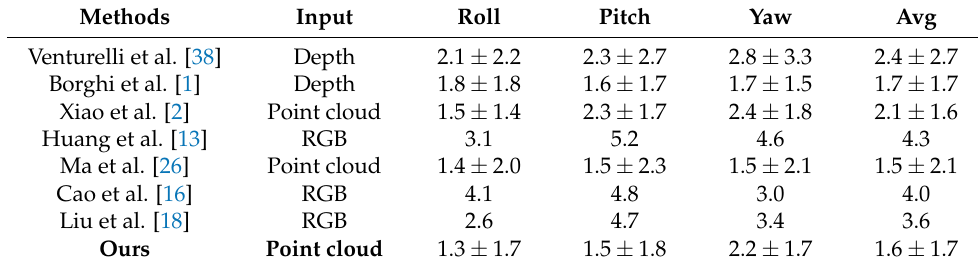
Table 4. Comparison of results achieved by different methods on the Biwi Kinect Head Pose dataset.